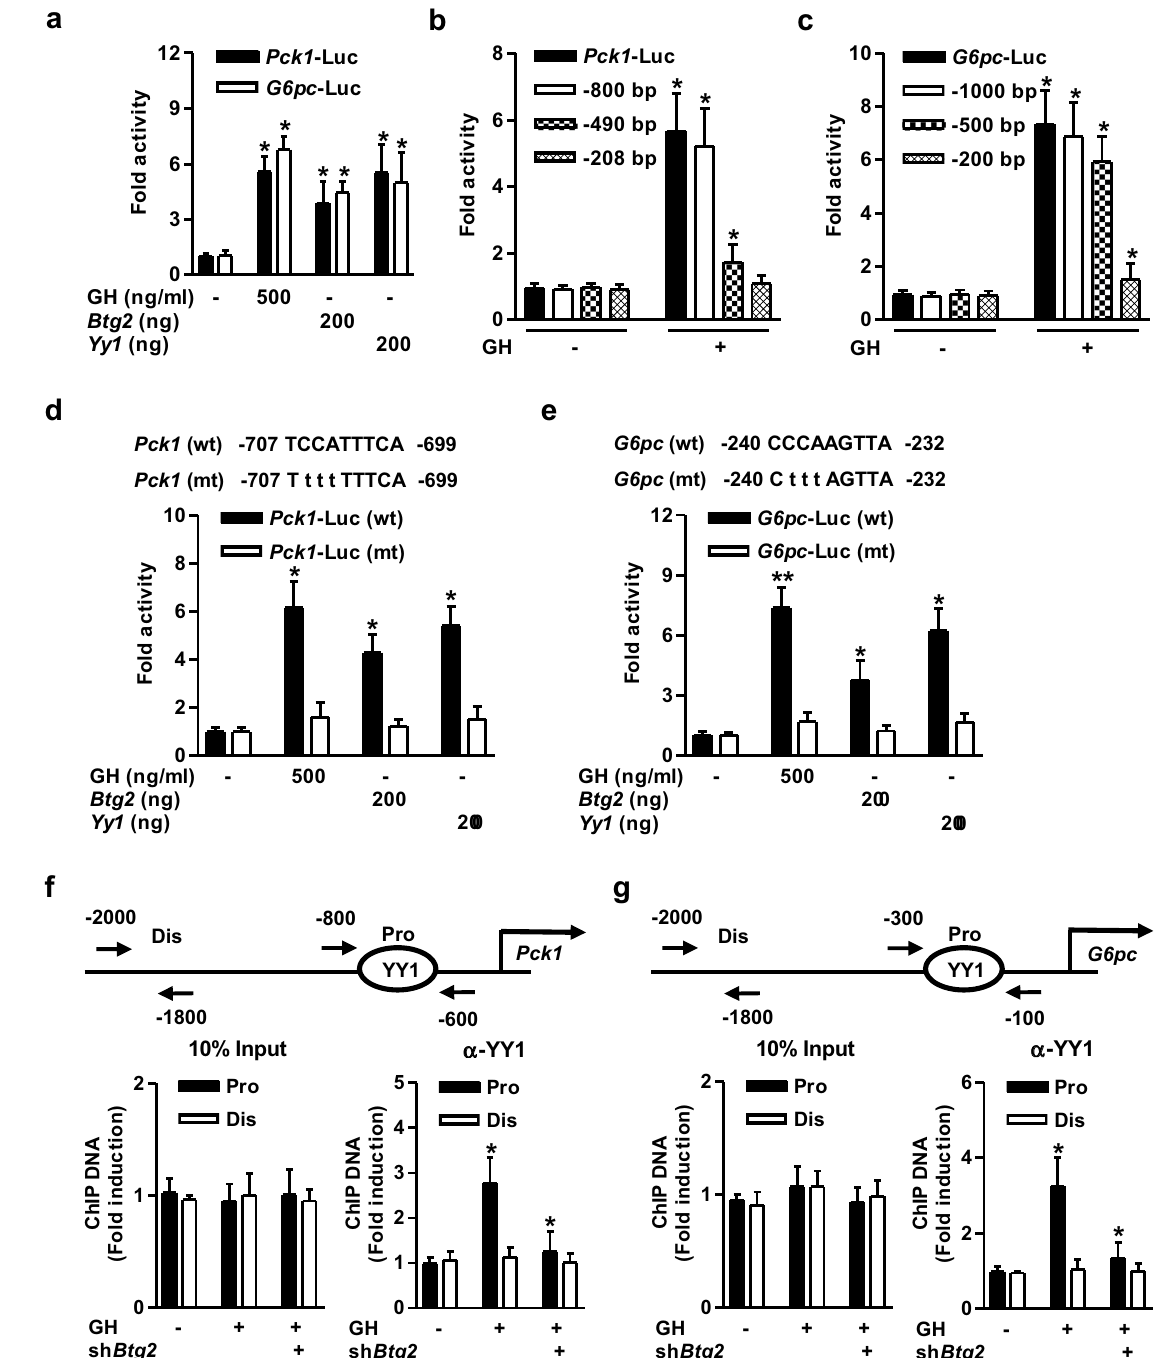
Figure 4. YY1 is a key regulator of hepatic gluconeogenic gene transcription. ( a ) AML-12 cells were transiently transfected with Btg2 , Yy1 , and the indicated reporter genes for 36 h. After transfection, the cells were treated with GH for 3 h. ( b , c ) AML-12 cells were transfected with wild-type and serial deletion forms of the Pck1 ( b ) and G6pc ( c ) reporter constructs for 36 h and then treated with GH for 3 h. ( d , e ) AML- 12 cells were cotransfected with wild-type (wt) and mutant (mt) forms of the Pck1 ( d ) and G6pc ( e ) gene promoter, Btg2 , and Yy1 for 36 h. After transfection, the cells were treated with GH for 3 h. Luciferase activity was normalized to β-galactosidase activity in each well. * P < 0.05, ** P < 0.01 vs. untreated control cells. ( f , g ) Chromatin immunoprecipitation (ChIP) assay for the recruitment of YY1 on the Pck1 ( f ) and G6pc ( g ) gene promoter. MPHs were infected with sh Btg2 for 36 h, and then treated with GH for 3 h. Cell lysates were immunoprecipitated with an anti-YY1 antibody. Purified DNA samples were used to perform PCR using primers binding to the specific proximal (Pro) and nonspecific distal (Dis) regions on the Pck1 ( f ) and G6pc ( g ) gene promoter. 10% of the soluble chromatin was used as an input. * P < 0.05 vs. untreated control or GH-treated